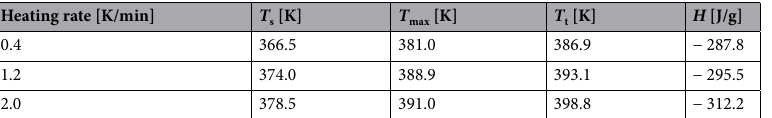
Table 1. DSC results for struvite → dittmarite conversion process. T s temperature of process start, T max temperature at maximum of energetic effect, T t temperature of process termination, H specific enthalpy of the process.